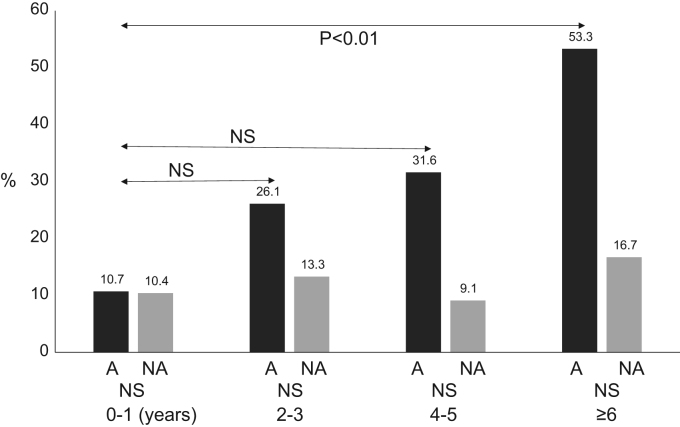
Positive coexisting or past allergic diseases rates (eczema, allergic conjunctivitis). A, asthma group; NA, Non-asthma group. The rates of coexisting allergic diseases were significantly higher in the older age groups than in the 0–1-year-old age group (NS, p< 0.01).